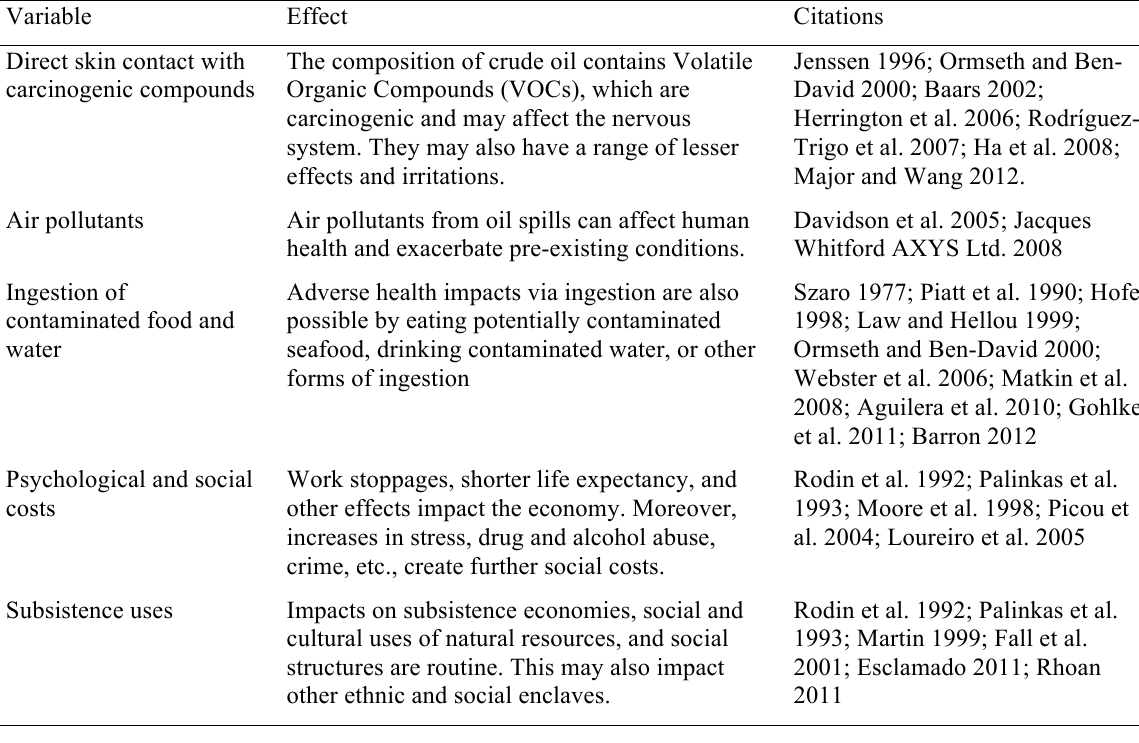
Table A1.5 Human health and society